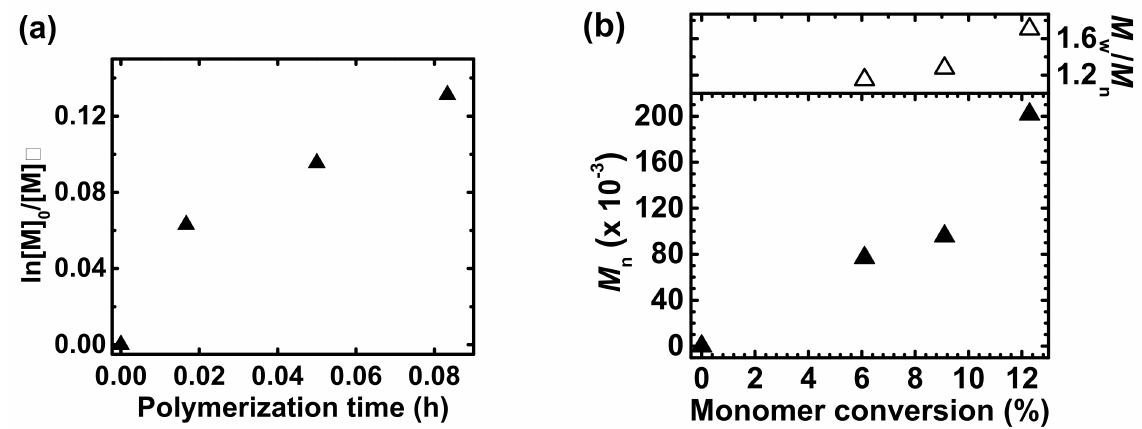
Figure 3. ( a ) First-order kinetic plot of monomer conversion vs. polymerization time of DMAEMA from the troxerutin core; ( b ) M n and M w / M n vs. monomer conversion. Table 1, entry